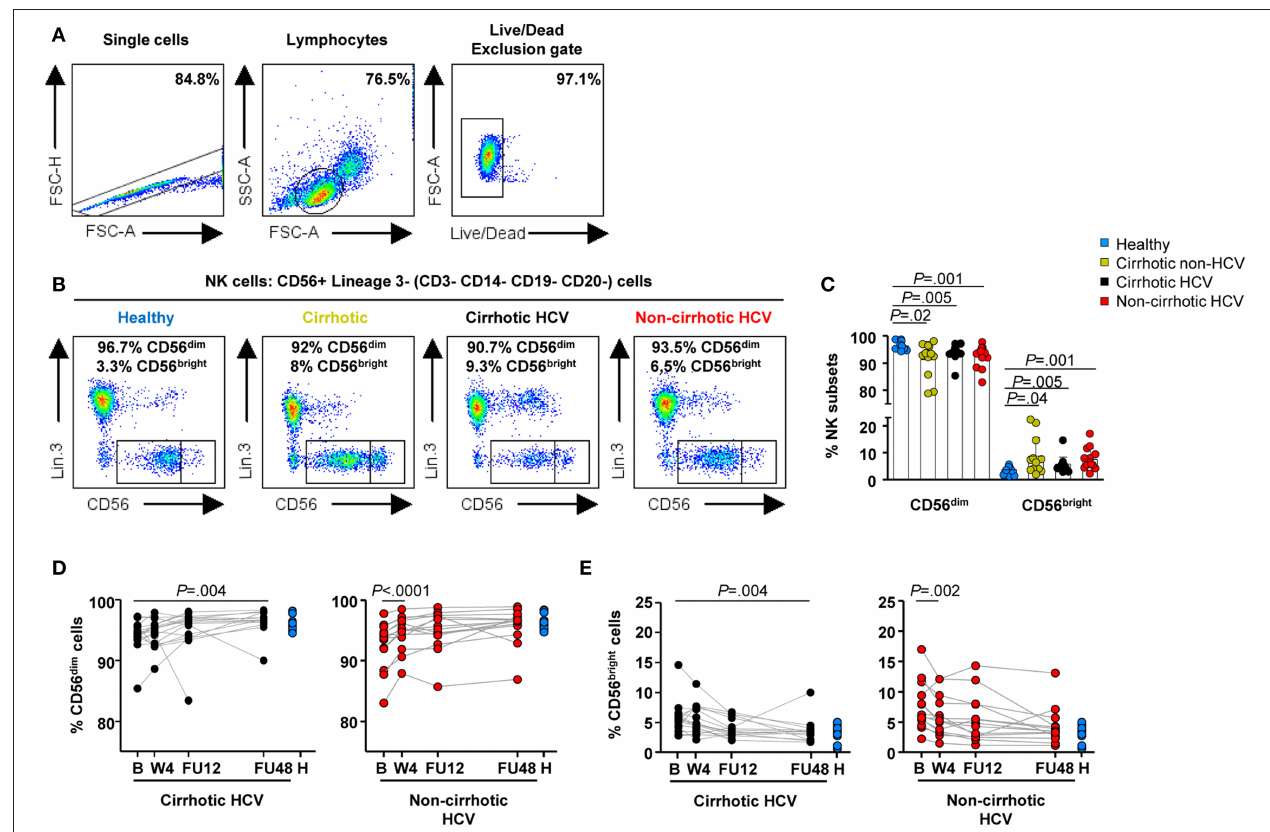
FIGURE 1 | Delayed normalization of frequencies of NK subpopulations in HCV patients with cirrhosis. Flow cytometric analysis of PBMC samples from 12 healthy individuals (blue), 12 non-HCV cirrhotic controls (yellow), 17 HCV cirrhotic (black), and 14 non-cirrhotic (red) patients. (A) Representative sequential gating strategy used to identify NK cells, followed by representative flow cytometry dot blots (B) depicting NK subpopulations based on the expression of CD56 (CD56 dim and CD56 bright cells). (C) Baseline frequencies of CD56 dim (left) and CD56 bright cells (right). Error bars indicate mean + SD; P -values were determined by Mann–Whitney U test. Longitudinal analysis during and after IFN-free therapies in HCV cirrhotic and non-cirrhotic patients of CD56 dim cells (D) and CD56 bright (E) cells. P -values were determined by using mixed models for repeated measurements.